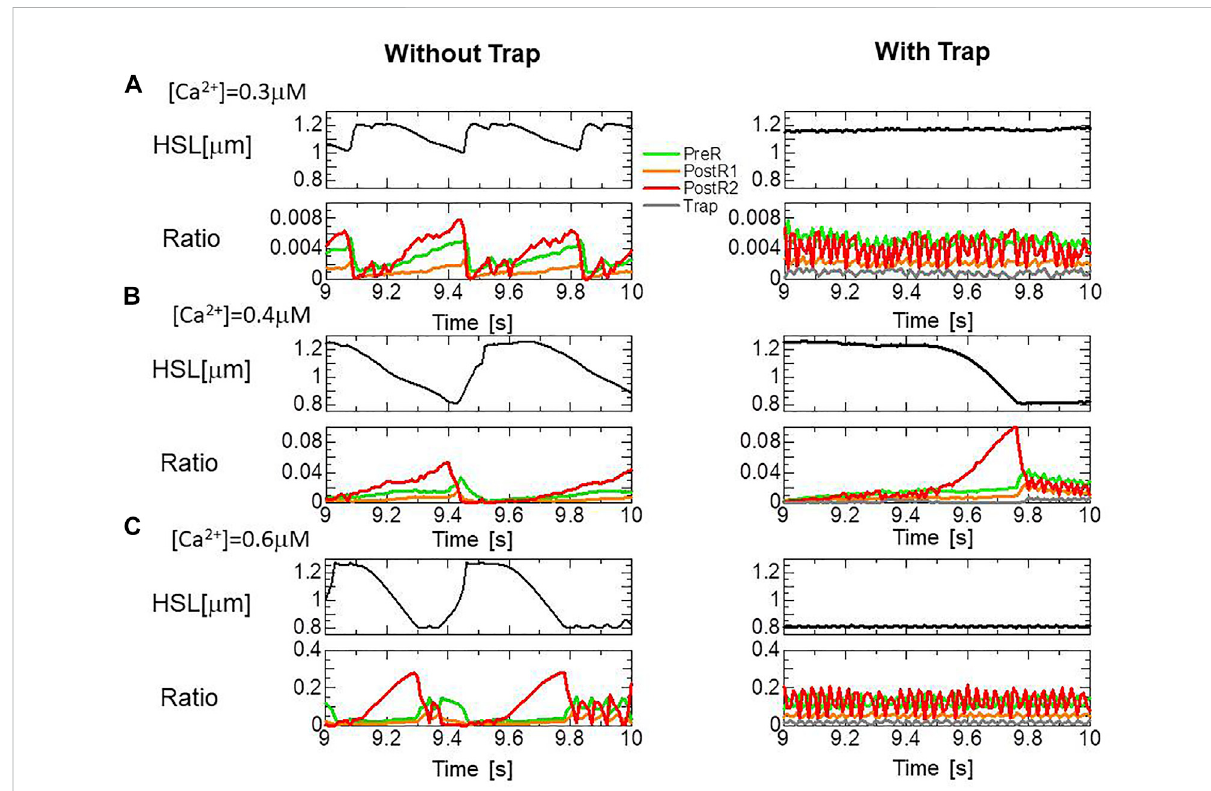
FIGURE 11 Transitionsofthefourattachedstatesfortheno-trapmodel(left)andthetrapmodel(right)duringSPOCsinahalf-sarcomeremodelimbedded in the myo fi bril model. Time courses are shown for the half-sarcomere length (black) and the population ratio of binding states: XB PreR (green), XB PostR1 (orange),XB PostR2 (red),andXB Trap (gray),fortheno-trapmodel(left)andthetrapmodel(right). (A) [Ca 2+ ]=0.3 μ M (B) [Ca 2+ ]=0.4 μ M,and (C) [Ca 2+ ] = 0.6 μ